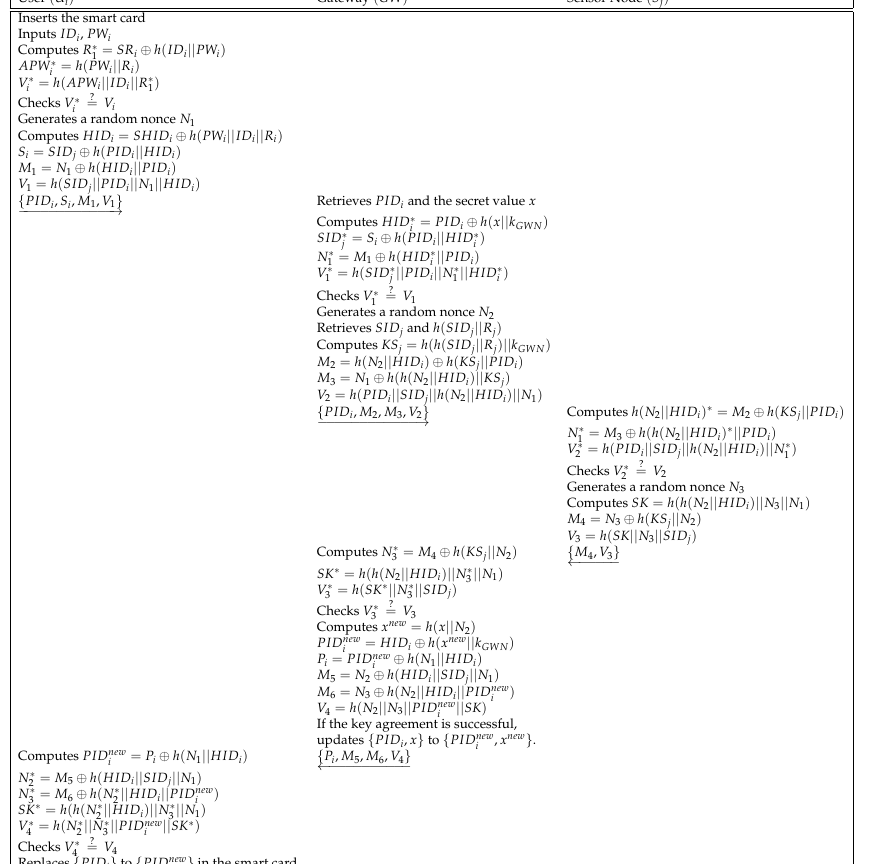
Figure 7. Login and authentication phase of